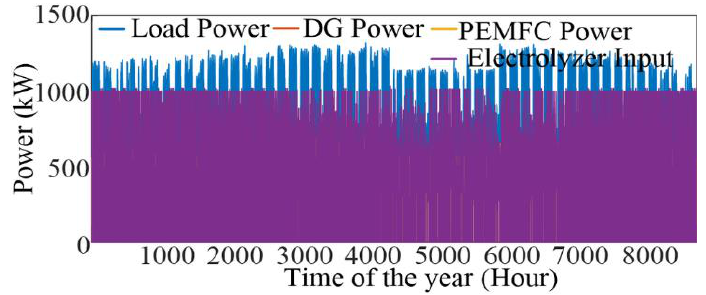
Figure 9. Power generation and consumption over the year: combination 2.